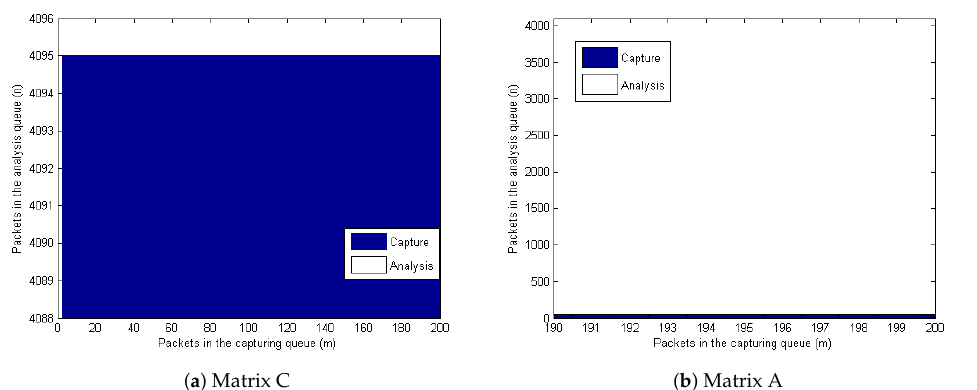
Figure 6. Optimal policy with network traffic rate of 1,100,000 pps and null analysis